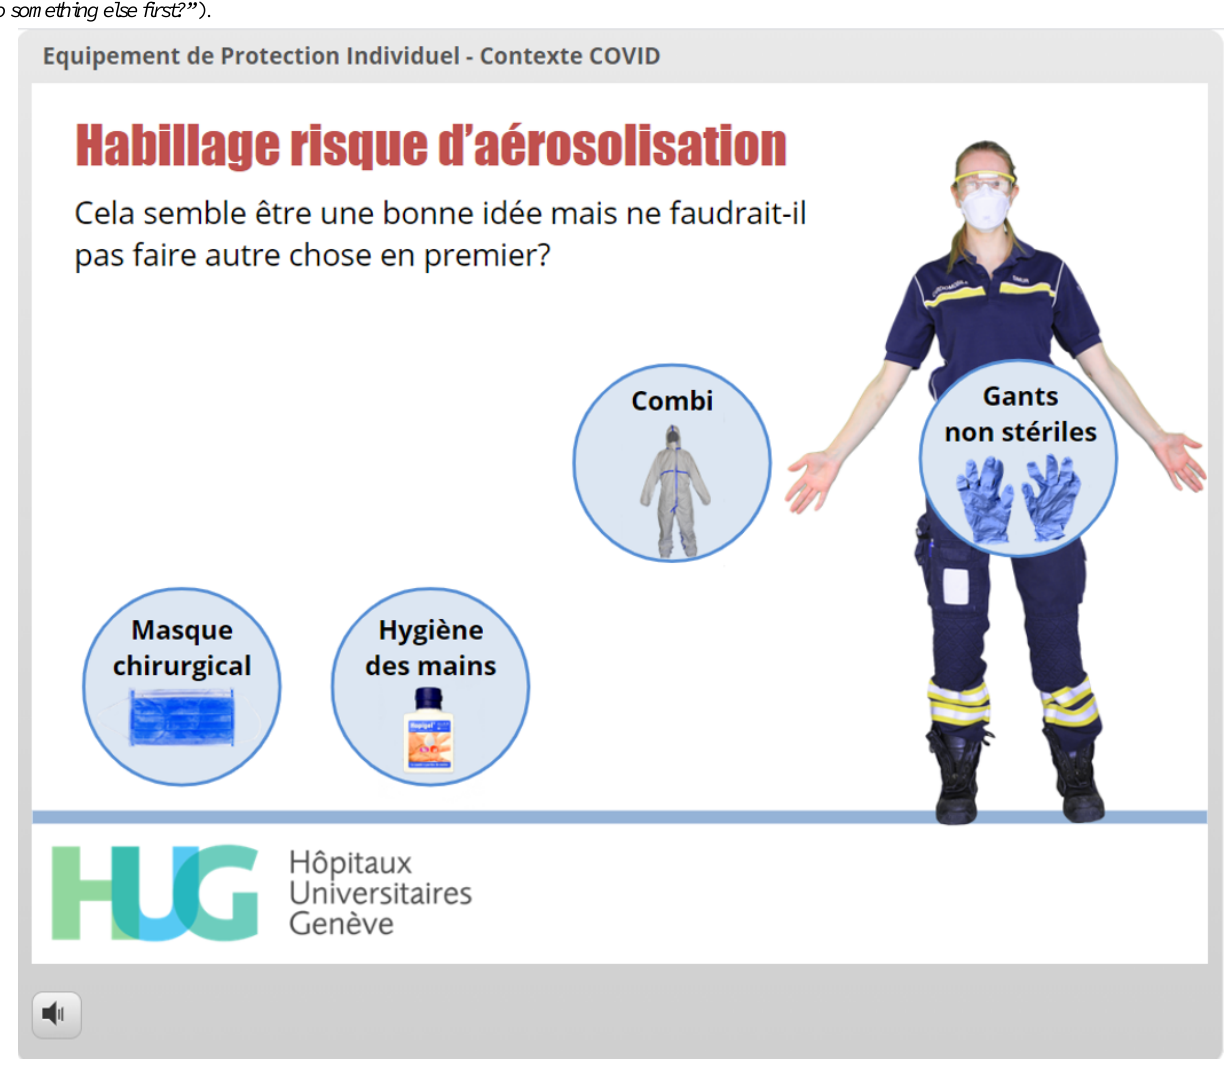
Figure 10. The learner has elected to try to put on gloves at this stage but is advised to try something else first without being given negative feedback ( “Cela semble être une bonne idée mais ne faudrait-il pas faire autre chose en premier?” which means “This looks like a good idea, but shouldn’t you do something else first?”